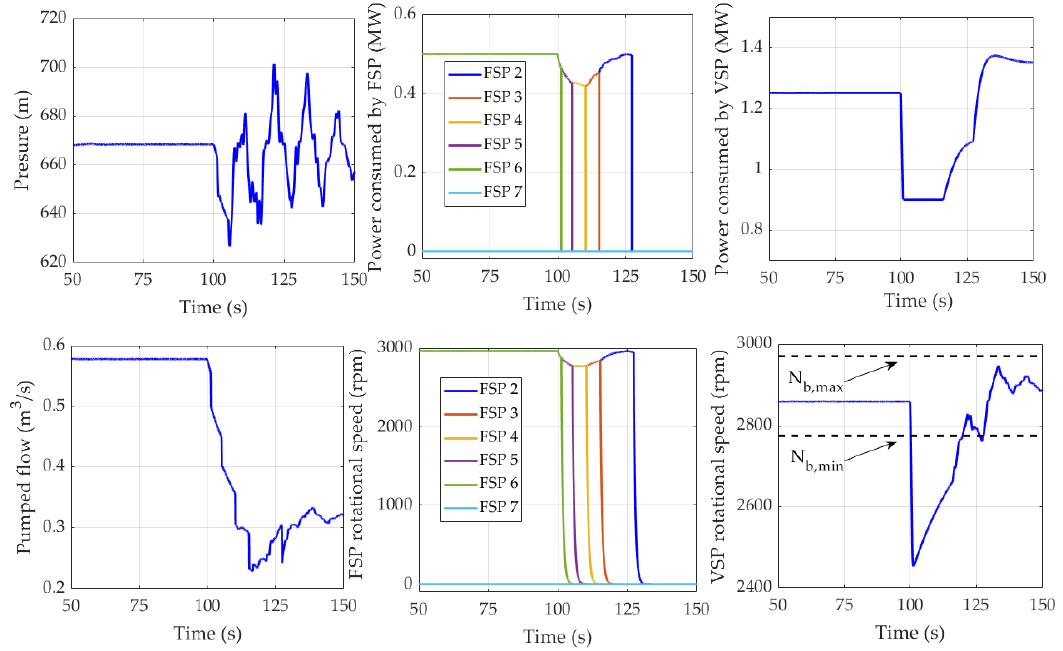
Figure 12. Pressure and flow in the penstock, pumps rotational speed, and power consumed when a VSWT disconnection takes place.